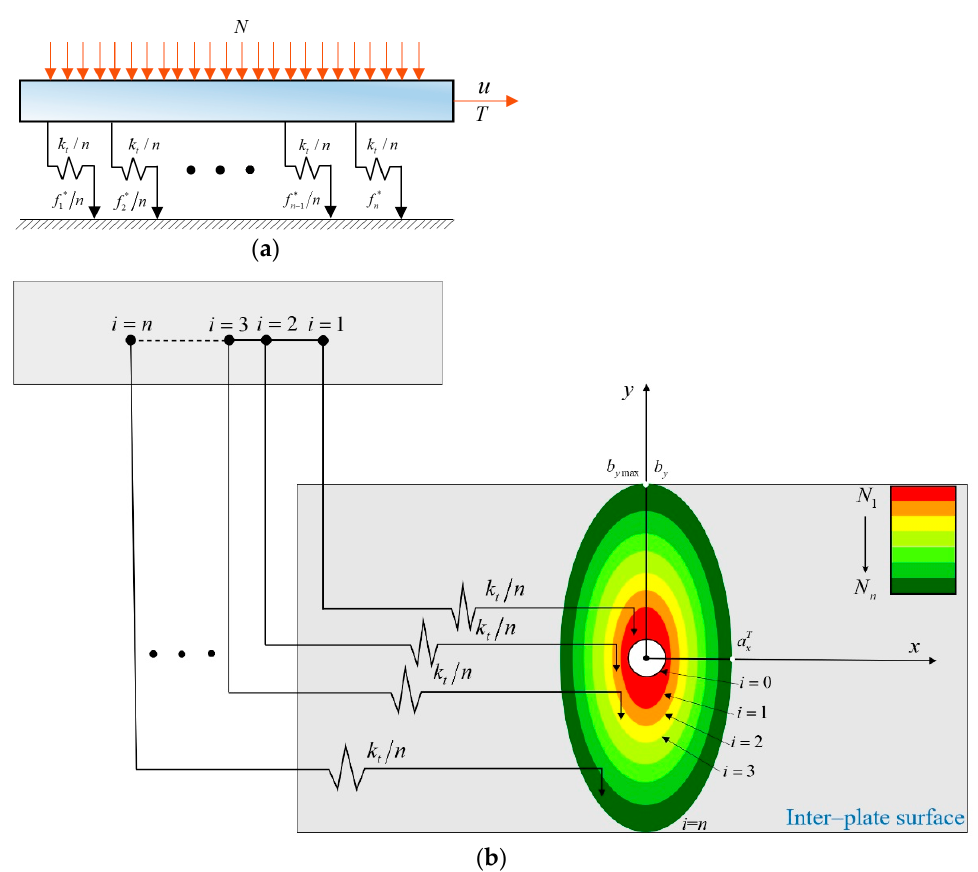
Figure 2. The dynamic Iwan modelling technique: ( a ) the constitutive model of the Iwan model; ( b ) the relationship between Jenkins elements and contact pressure. ( a T x is the semi-minor axis of the outermost elliptical contact boundary; b y max is the semi-major axis in microslip).